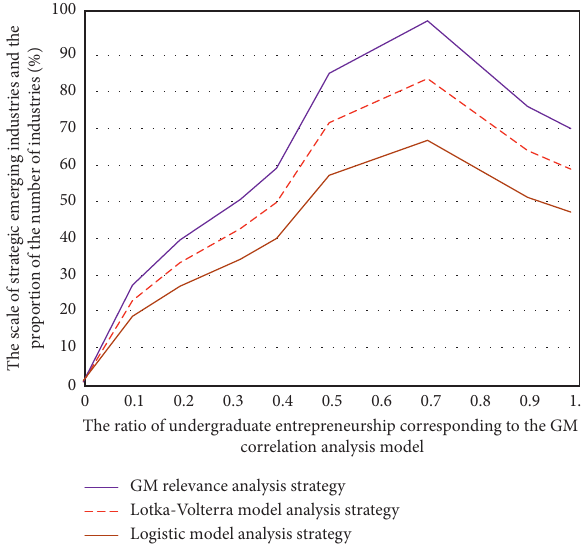
Figure 6: Statistics on the development of emerging industries for college